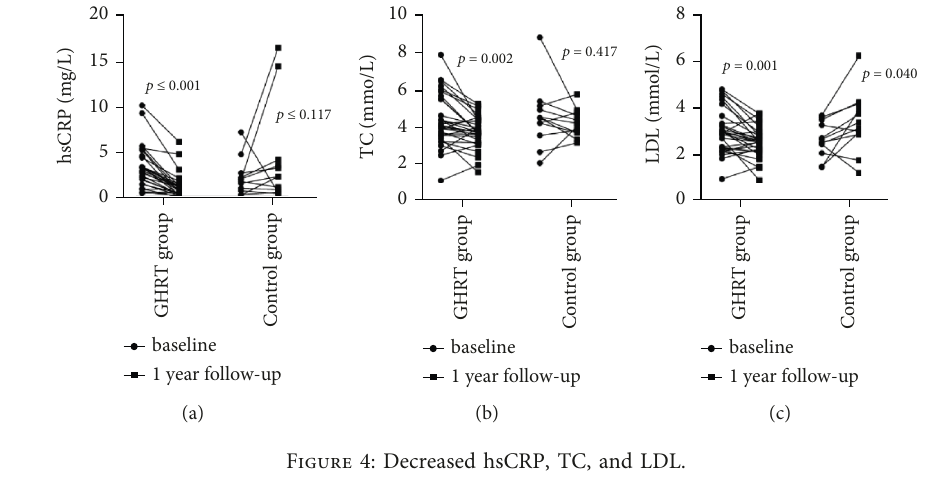
Figure 4: Decreased hsCRP, TC, and LDL.